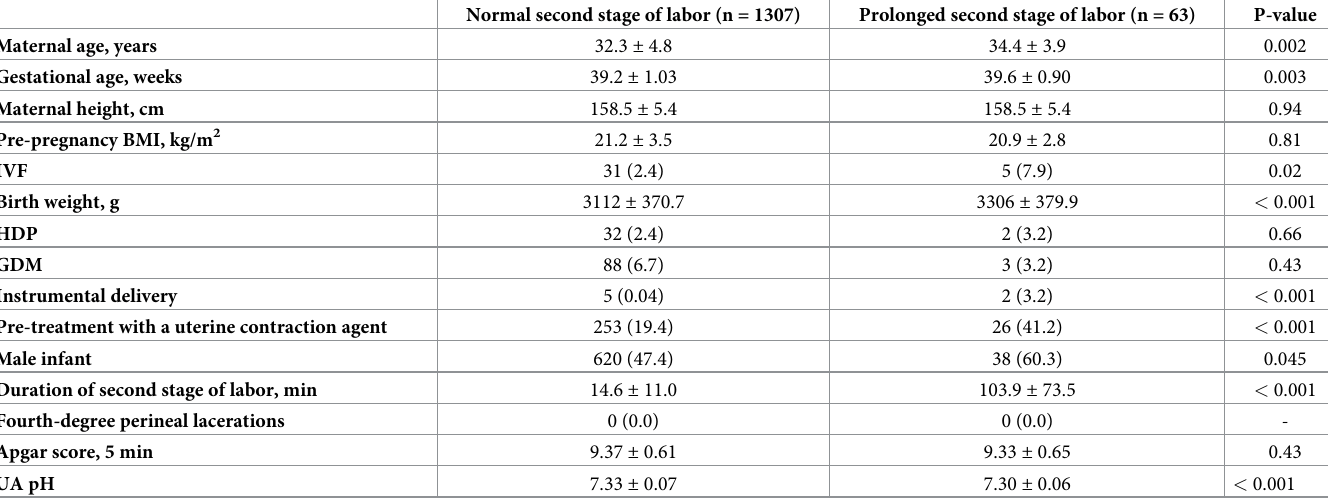
Table 6. Baseline characteristics of multiparous women in the study population.